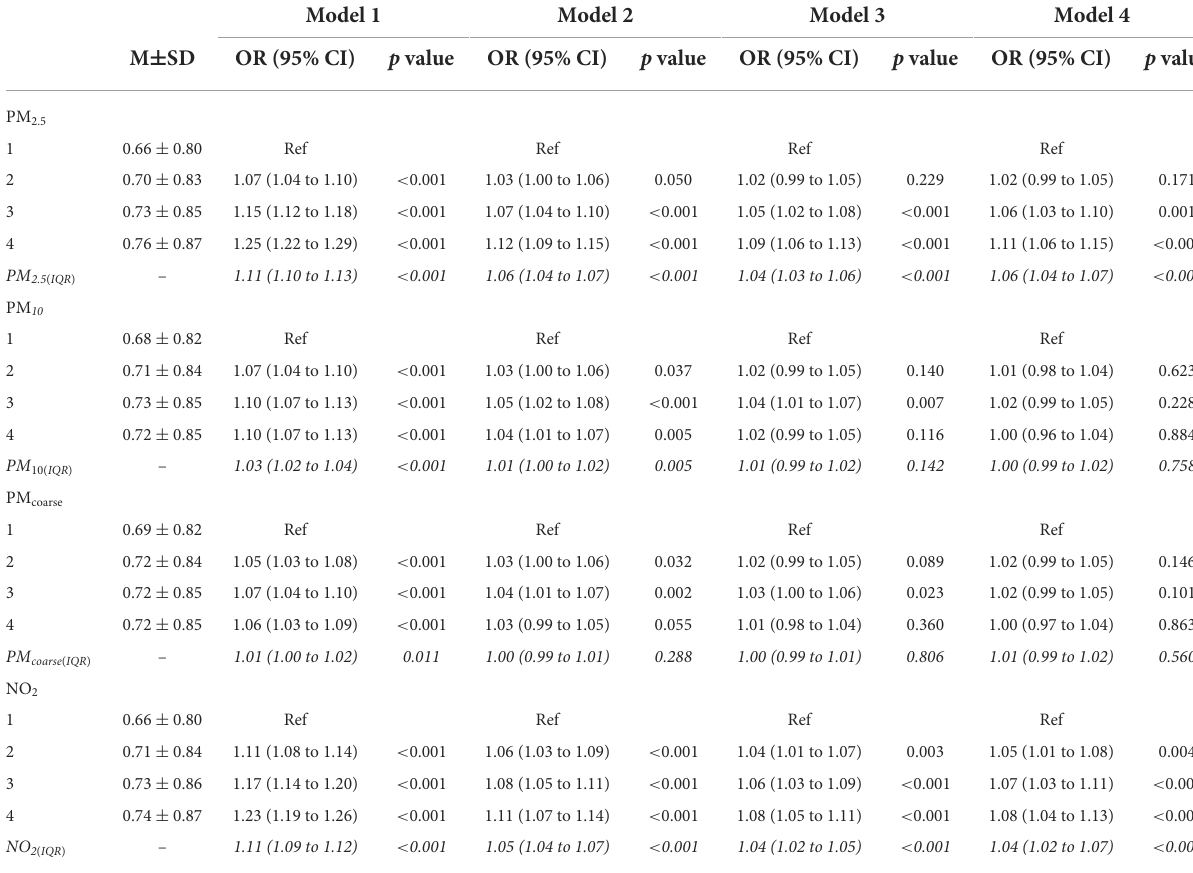
TABLE 2 Associations between IQR increments in air pollution ( italics ), air pollution quartiles and multimorbidity severity scores in people with multimorbidity ( N =